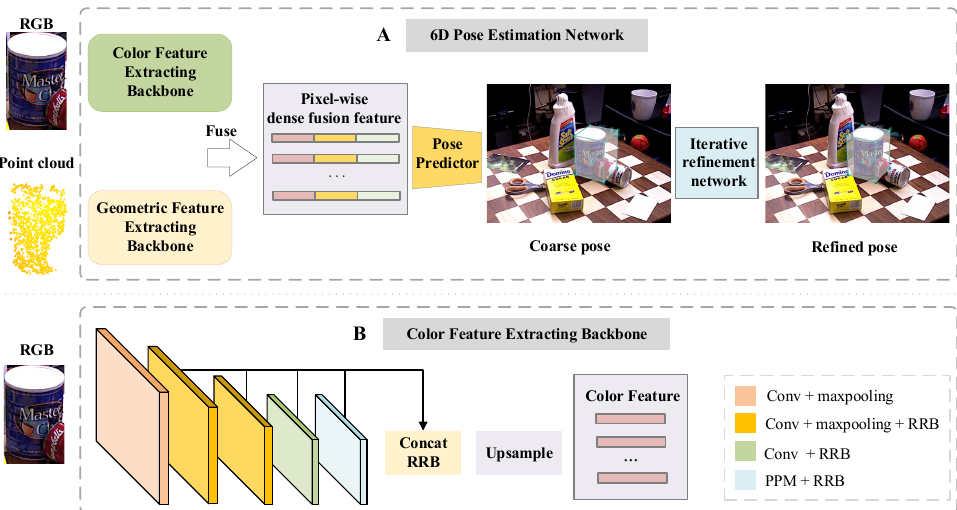
Figure 8. The overall framework of the 6D pose estimation network. ( A ) 6D pose estimation network: Firstly, the color and geometric features are extracted from two backbones and fused at the pixel level. Then, a predictor is used to regress the pose. Finally, the iterative refinement network is used to refine the pose. ( B ) Color Feature Extracting Backbone: Our backbone is based on ResNet18, for detail, the output of layer2, layer3, and layer4 and the output of PPM go through an RRB module to strengthen the features. Then the features are fused from different scales to improve the expressiveness of